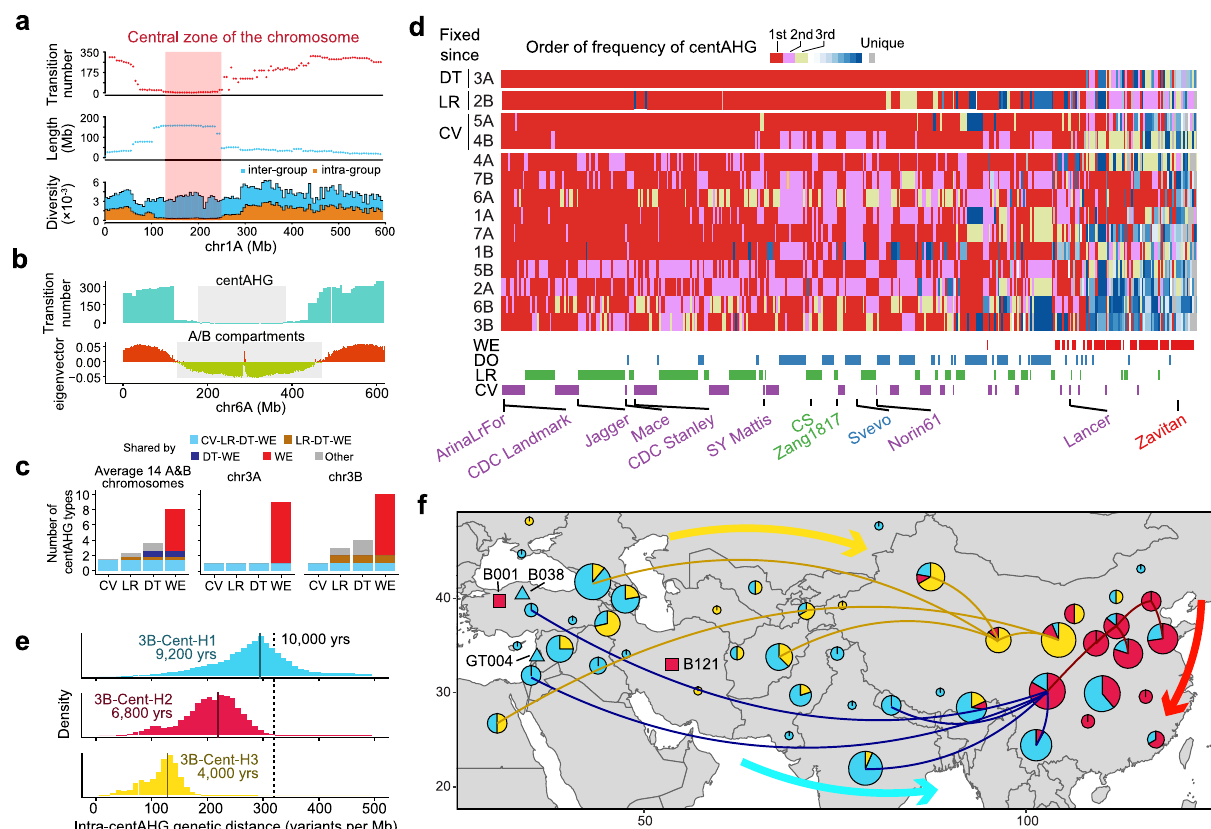
Fig. 5 Centromeric ancestral haplotype group (centAHG) acts as the chromosome backbone in evolution. a Positioning of centAHGs on chromosome 1 A, based on the time of transition among AHG types between adjacent windows (upper), length of consecutive windows of the same type of AHG (middle) and ratio between inter- and intra- AHG type genetic diversity (lower) of all 386 accessions. b The consistency between the partition of the centAHG and the A/B compartment from a previously published study 49 on chr6A. c Proportion of centAHGs among four taxonomic groups that could be traced back through the route of WE-DT-LR-CV of 14 A&B chromosomes shown by stacked bar chart. d Distribution of centAHGs in A&B chromosomes among 386 samples. The color index corresponds to the order based on frequency of centAHGs on each chromosome. Accessions are ordered by the overall frequency of centAHGs they contain. The diversity-based order of chromosomes revealed the stepwise fi xation of centAHGs. The taxonomic group of each accession and name of selected accessions are shown. e Distribution of pairwise genetic distances among accessions from 3 main 3B centAHGs with correspondingly estimated divergence times labeled. f The potential dispersal routes of the initial introduction of hexaploid wheat to East Asia. Routes (curves) were inferred from the phylogenetic relationship of the three main 3B centAHGs in landraces (pie chart) and directions (arrows) were determined by manual consolidation of the literatures. An additional 281 landraces from previously published studies with geographical information available were added 5,18,48 . The geographical locations of WE accessions carrying 3B-Cent-H1 and DT accessions carrying 3B-Cent-H2 and 3B-Cent-H3 are labeled.